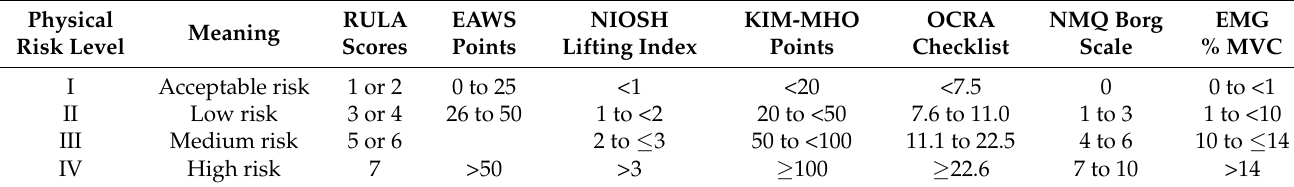
Table 1. Physical risk levels based on the output scores of each ergonomic method.